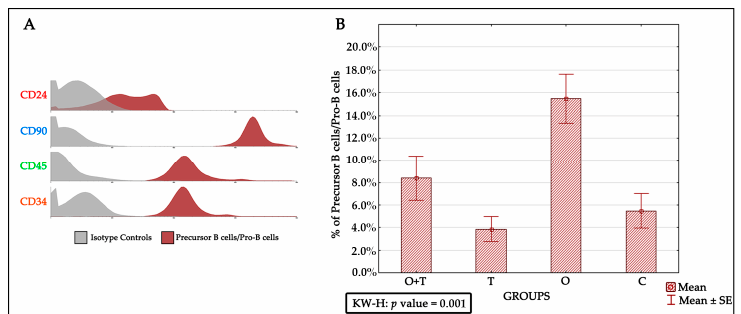
Figure 4. ( A ) Histogram indicating markers of precursor B cells/Pro-B cells in each studied group. These cells are characterized by appearances of CD24 +, CD90 +++, CD45 ++, and CD34 ++; and ( B ) Graph of the percent of precursor B/Pro-B cells in each group and the result of the Kruskal- Wallis statistical test, p value = 0.001.